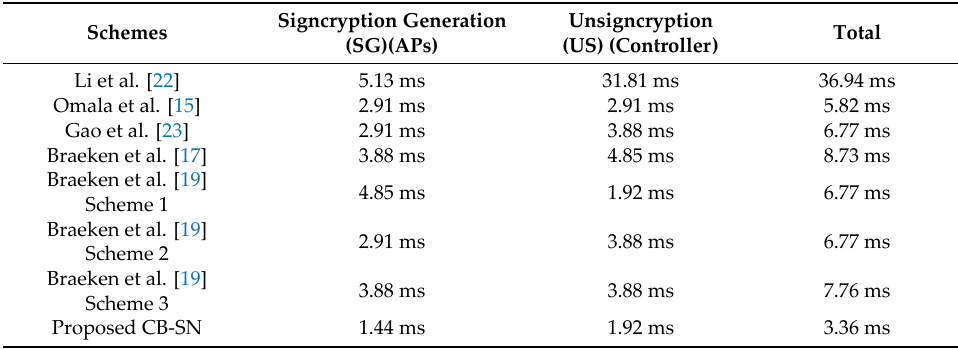
Table 4. Computational cost comparison in